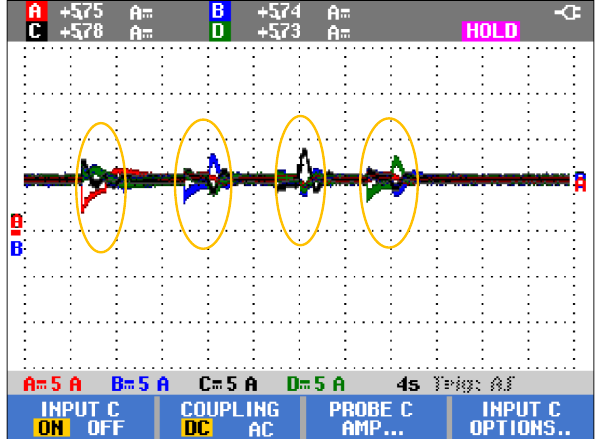
Figure 16. DGU voltages during sequential voltage attacks.